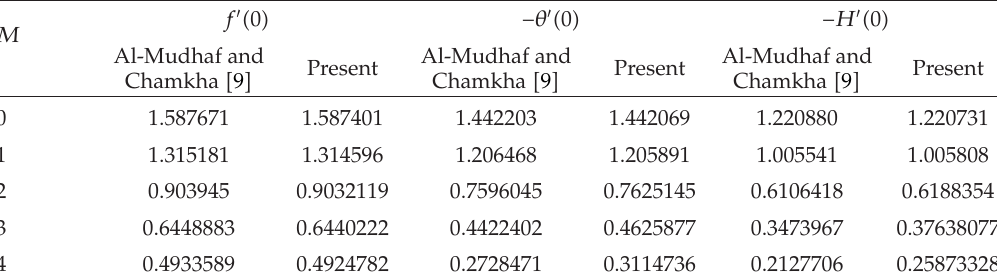
Table 1: Comparison values of f (cid:5) (cid:5) 0 (cid:6) , − θ (cid:5) (cid:5) 0 (cid:6) and − H (cid:5) (cid:5) 0 (cid:6) with di ff erent parameter M .